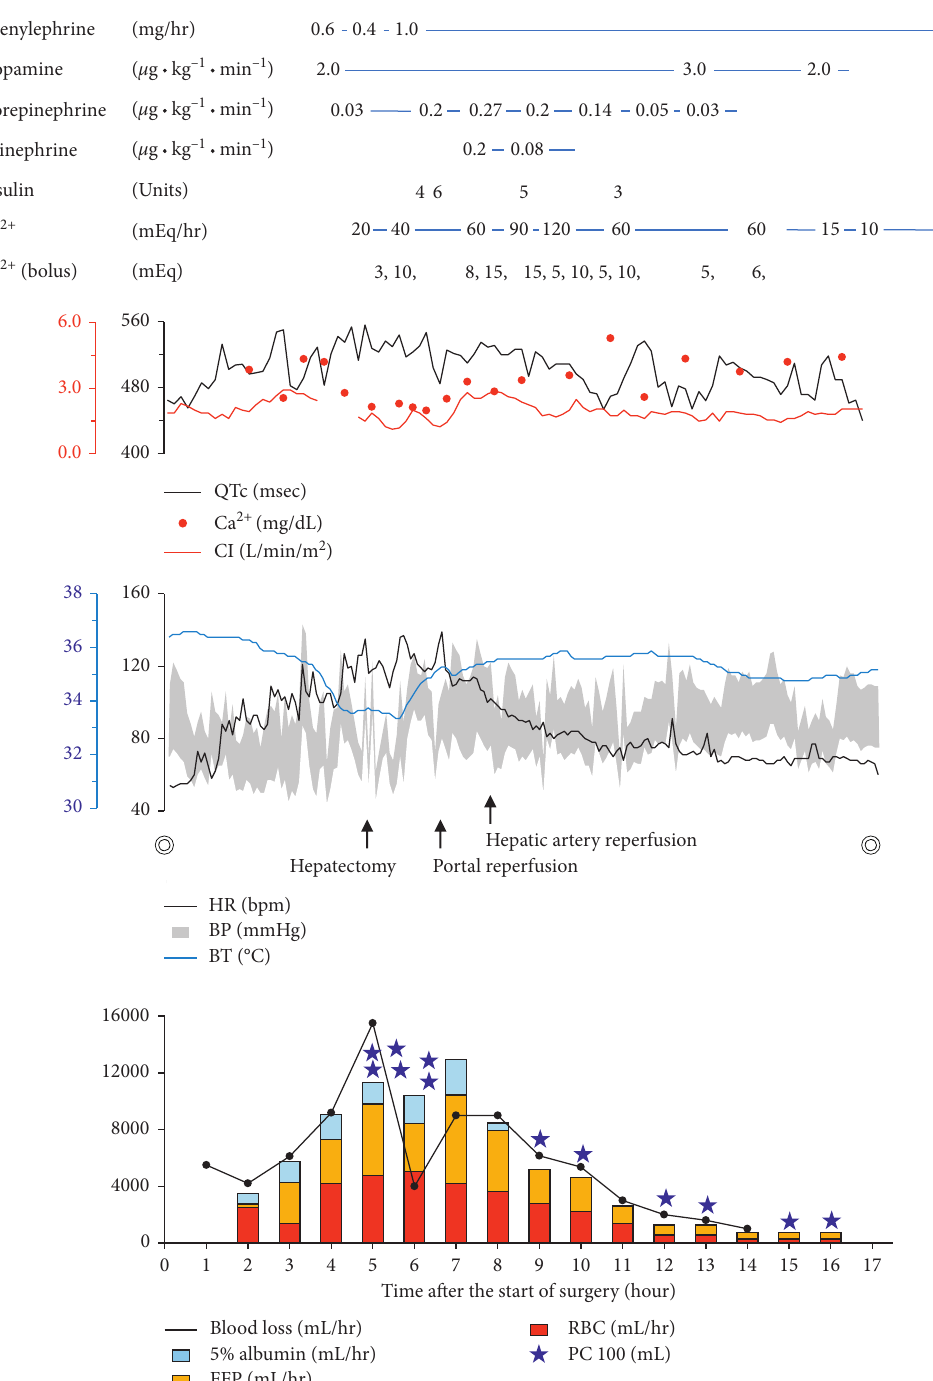
Figure 2: Overview of the anesthetic chart. The dosages of drugs are shown in the upper part. Serial changes in QTc interval (QTc), Ca 2+ , cardiac index (CI), hemodynamics, and body temperature (BT) are shown in the middle part. Approximate amounts of blood loss and transfusion (mL/hr) are shown in the bottom part. Time indicates time after the start of surgery. The double circles indicate the start and end of the surgery. HR, heart rate; bpm, beats per minute; BP, blood pressure; FFP, fresh frozen plasma; RBC, red blood cell concentrates; PC, platelet